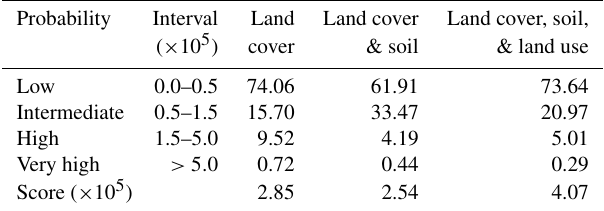
Table 1. Relative areas (%) per ignition probability class for the three IPMs and the average probability assigned to the ignition points.